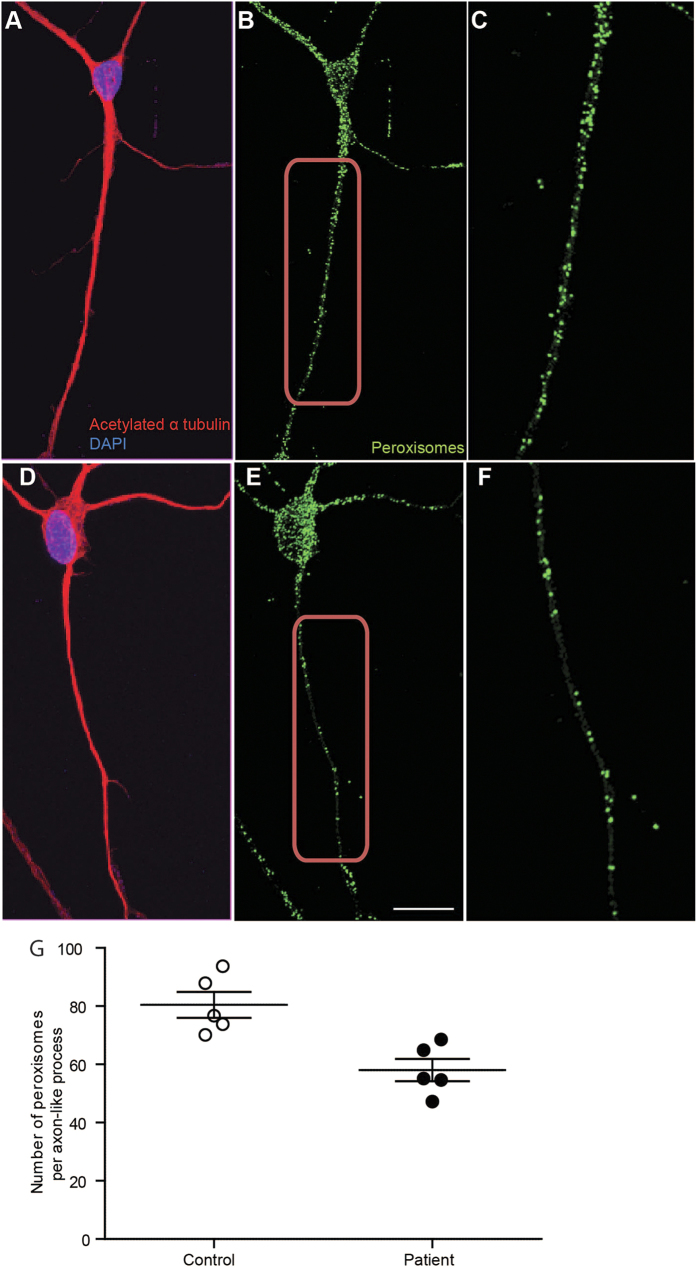
Reduced peroxisome number in axon-like processes of differentiated patient cells.(A) Control differentiated cells immunostained with an antibody to acetylated α-tubulin (red), and DAPI to label nuclei (blue). (B) The same cell immunostained with an antibody to the peroxisomal membrane protein PEX14 (green). (C) Higher magnification view of the boxed area in (B), showing the individual peroxisomes in axon-like process. (D) Patient differentiated cell immunostained with an antibody to acetylated α-tubulin (red), and with DAPI (blue). (E) The same cell immunostained with an antibody to PEX14 (green). (F) Higher magnification view of the boxed area in (E), showing the individual peroxisomes in the axon-like process. Scale bar in E applies to (A,B,D,E) 20 μm. (G) Peroxisome numbers were quantified along 100 μm of axon-processes starting 20 μm from cell body (example shown in C,F). 4022 peroxisomes were quantified from 50 axon-like processes of 5 control cell lines and 2903 peroxisomes were quantified from 50 axon-like processes of 5 patient cell lines. Average numbers of peroxisomes/axon-process of all patient cell lines (solid circles) were compared to all control cell lines (open circles). N = 5 cell lines per group; unpaired t-test; two tailed; p-value: 0.0052; t = 3.808 df = 8. Data are represented as Mean ± SEM.